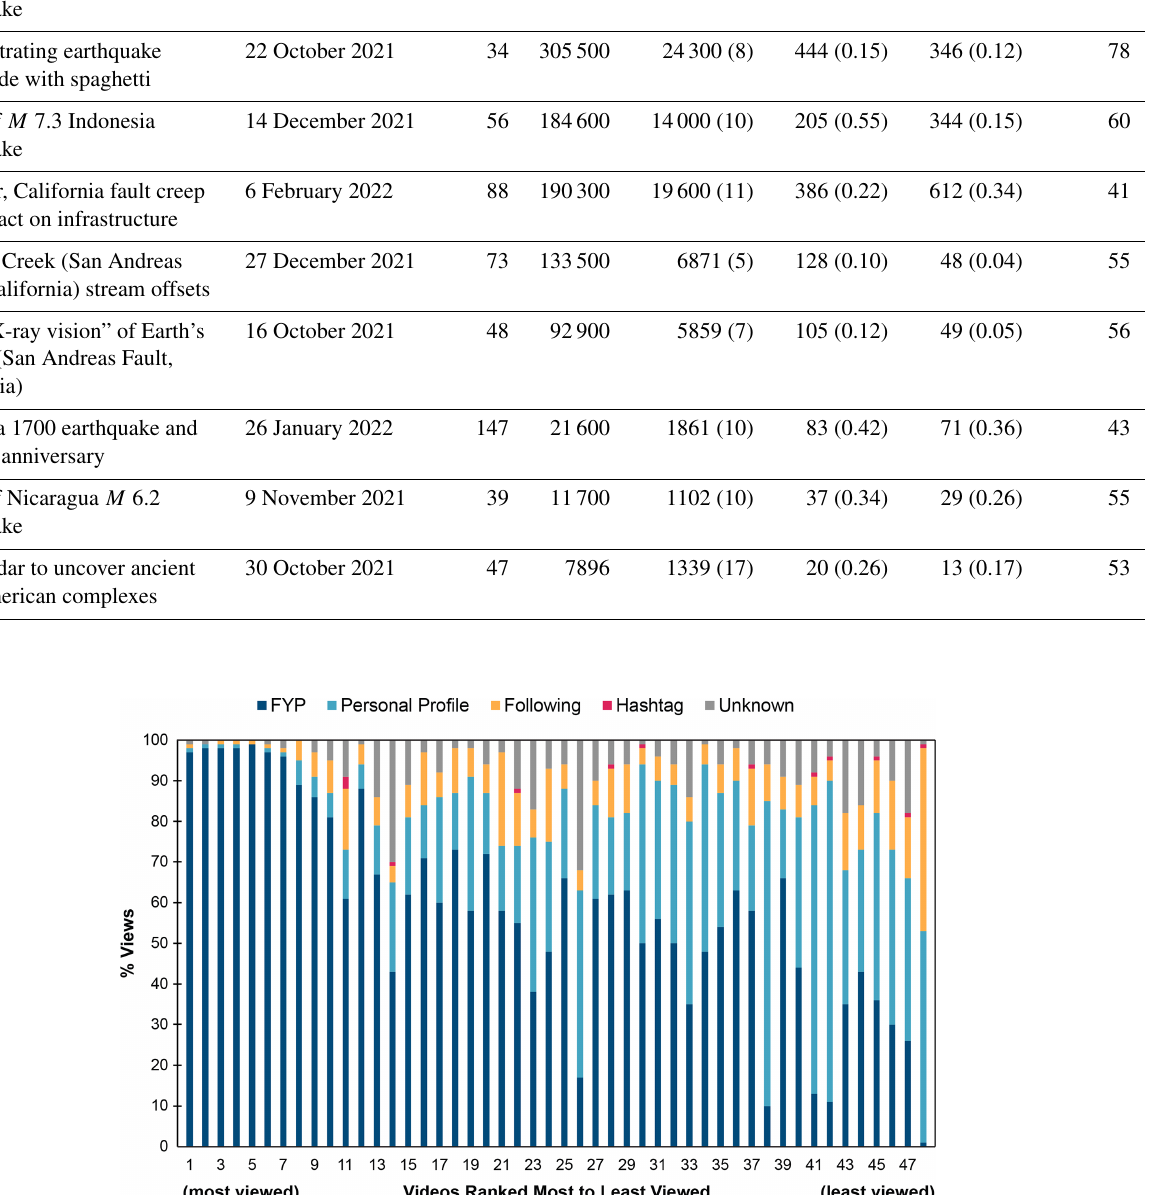
Figure 4. Percentage of video views by section ( For You page, personal profile, Following , hashtag, unknown), with videos ranked from the most (1) to the least (48) viewed (see Tables 2 and 3 for the 10 most and 10 least-viewed videos). The videos with the highest number of views received nearly all ( ∼ 97%) of their views from the For You page. The seven most-viewed videos each received over 90000 views.